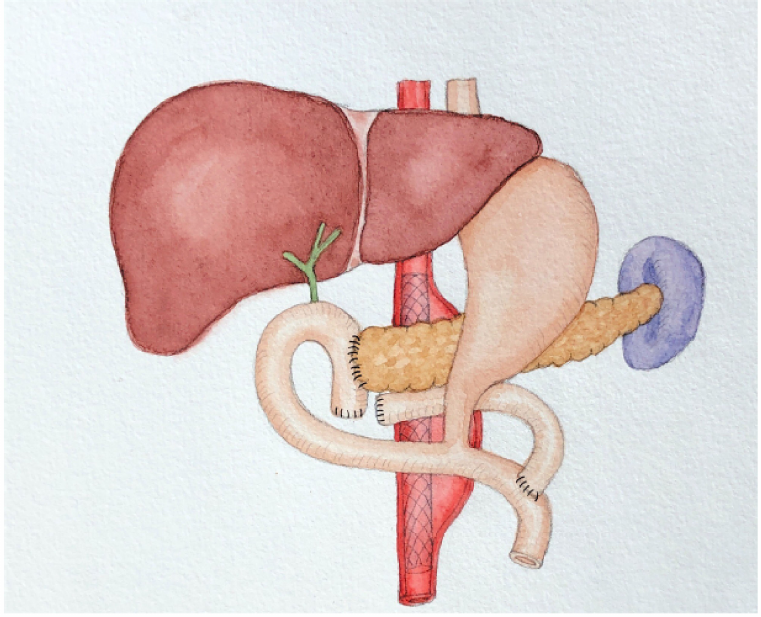
Figure 2. Modified PPPD. PPPD: pylorus-preserving